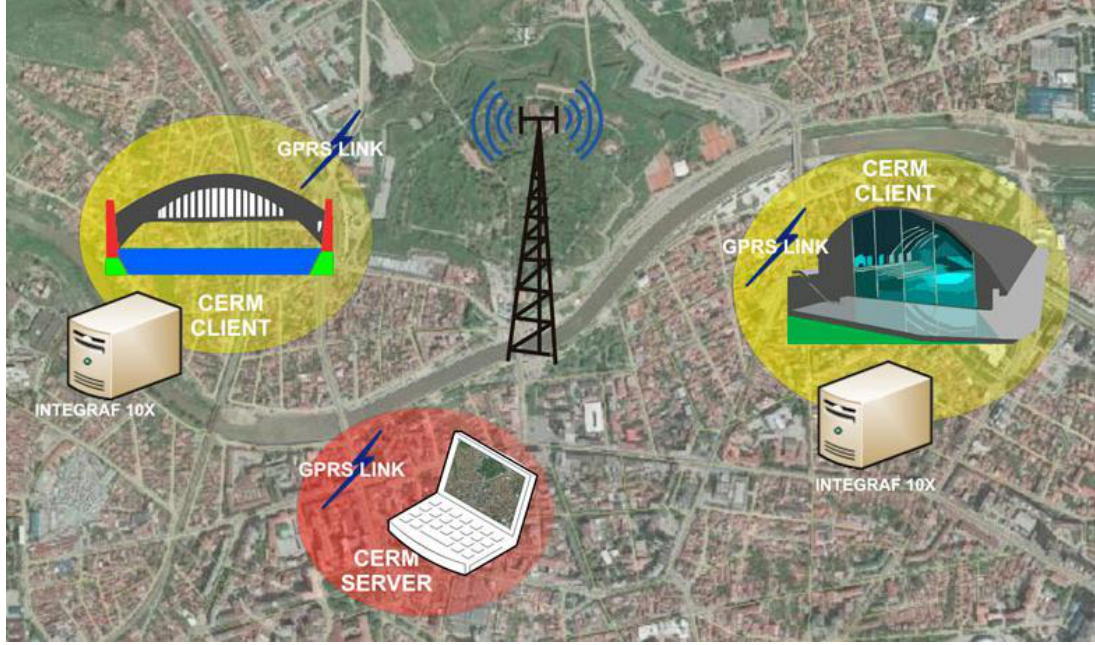
Figure 4. CERM as a central information